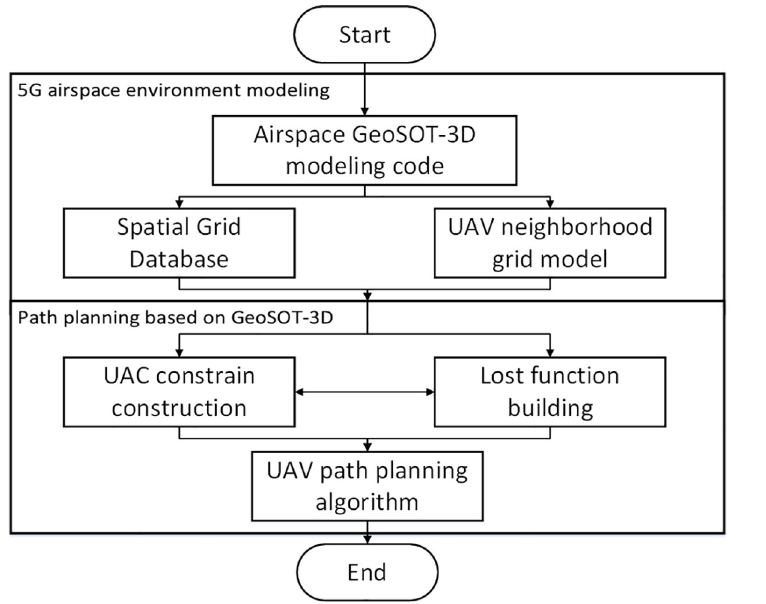
Fig 4. UAV trajectory planning process in 5G signal field